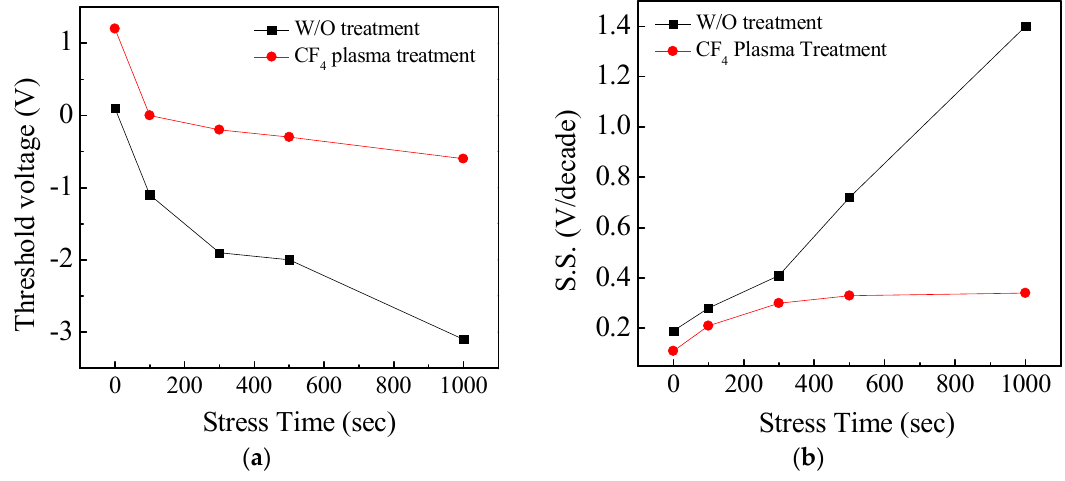
Figure 6. ( a ) V th ; ( b ) S.S. as function of PGBS time of a-IGZO TFT.